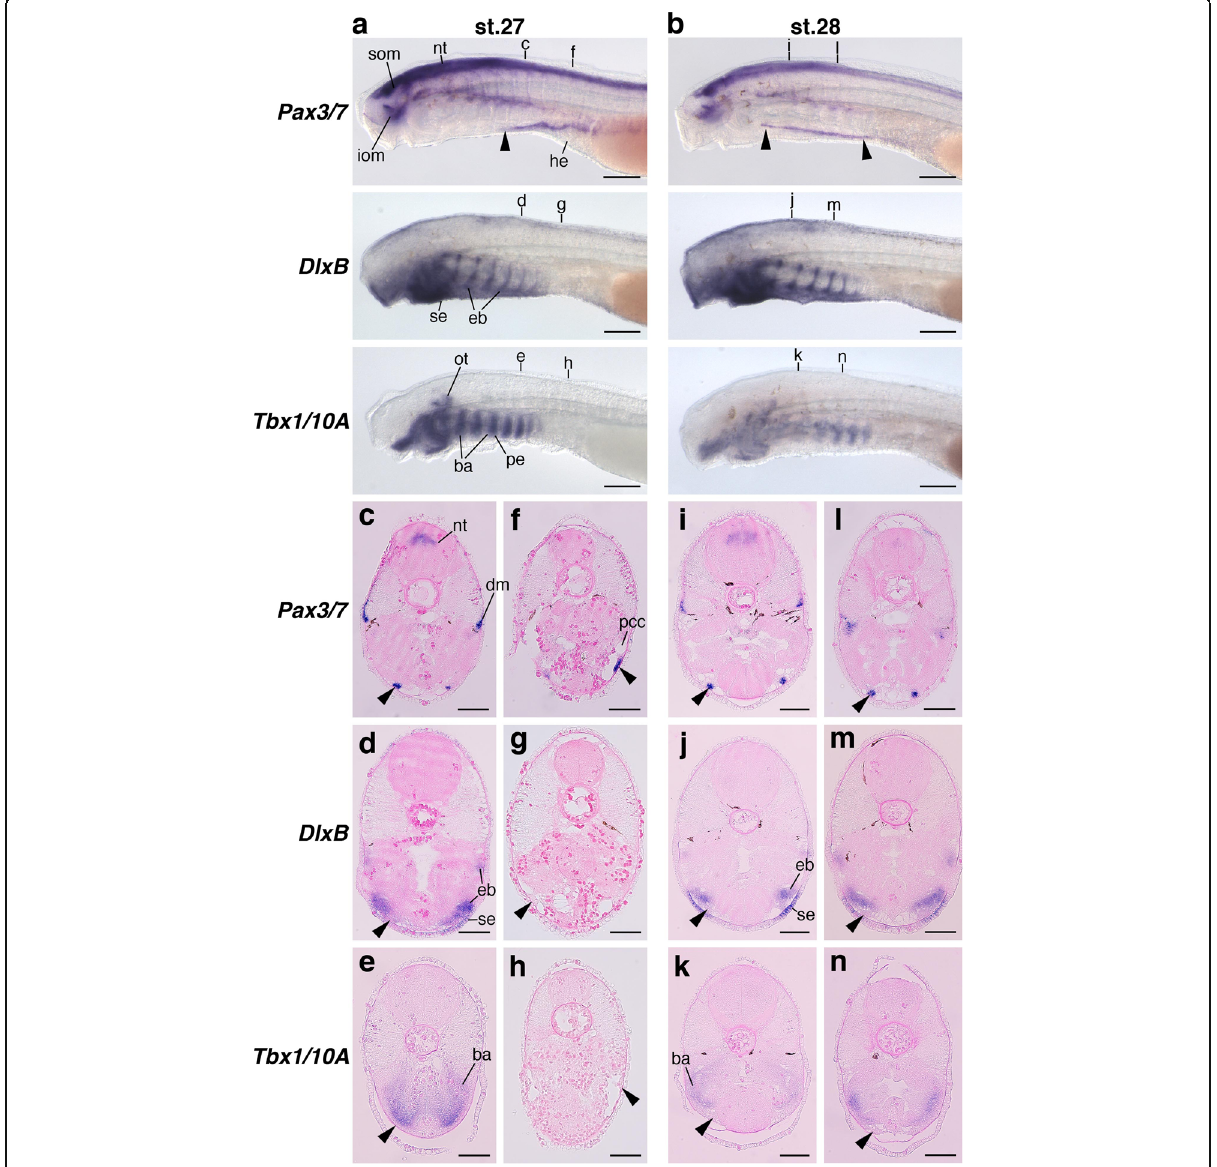
Fig. 7 The arrangement of HBMs pathways and pharyngeal arches in lamprey embryos. Pax3/7 , DlxB and Tbx1/10A expressions in lampreys at stage 27 ( a ) and 28 ( b ) from the lateral view. Transverse sections of stage 27 embryos at the fifth branchial arch ( c – e ) and heart ( f – h ) levels, and stage 28 embryos at the second ( i - k ) and fourth branchial arch ( ln ) levels. Section levels are indicated in ( a ) and ( b ). Arrowheads indicate HBM precursors. Pharyngeal arches and the pericardium were not in the same transverse plane, and HBM precursors expanded lateral to the pharyngeal arches. ba, branchial arch mesoderm; dm, dermomyotome; eb, ectomesenchyme of branchial arches; he, heart; iom, infraoptic muscle; nt, neural tube; ot, otic vesicle; pcc, pericardial cavity; pe, pharyngeal endoderm; se, surface ectoderm; som, supraoptic muscle. Scale bars on whole embryos, 200 μ m. Scale bars on sections, 50 μ